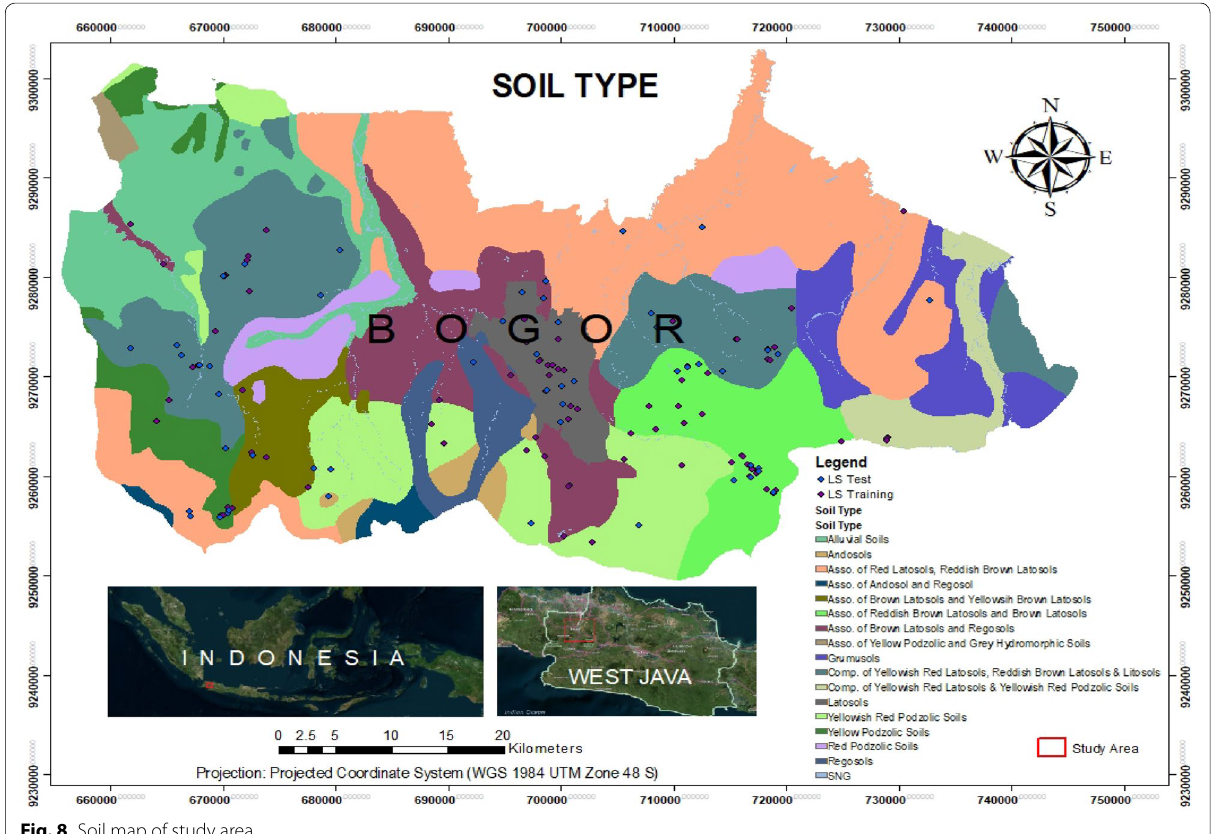
Fig. 8 Soil map of study